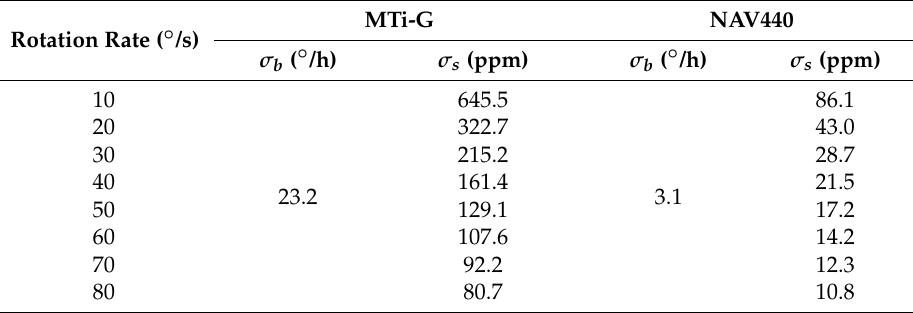
Table 6. Calibration errors caused by gyro noise for tested